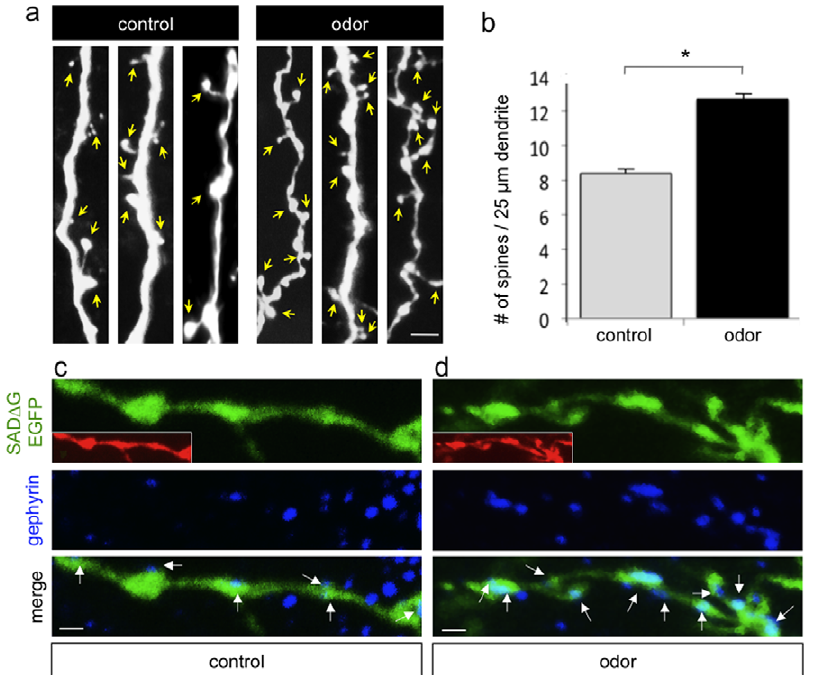
Figure 5. Odor Stimulation Increases Synaptic Inputs onto Newborn Granule Cells. (a) Dendrites from granule cells in control or odor exposed mice showing the increased number of spines following odor enrichment. Yellow arrows point to individual spines. Scale bar, 3 m m. (b) Data represent means 6 SEM of spine number per 25 m m dendrite on granule cells in mice exposed to cycled odorants (odor) compared to non-odor exposed controls. * p , 0.001, Student’s t-test. (c) Gephyrin labeling to reveal inhibitory GABAergic synapses on control granule cell dendrites. Insets in (c) and (d) show tdTomato expression in doubly labeled dendrites. Scale bars, 2 m m. (d) Increased number of gephyrin labeled inhibitory synapses contacting dendrites of granule cells from mice subjected to odor